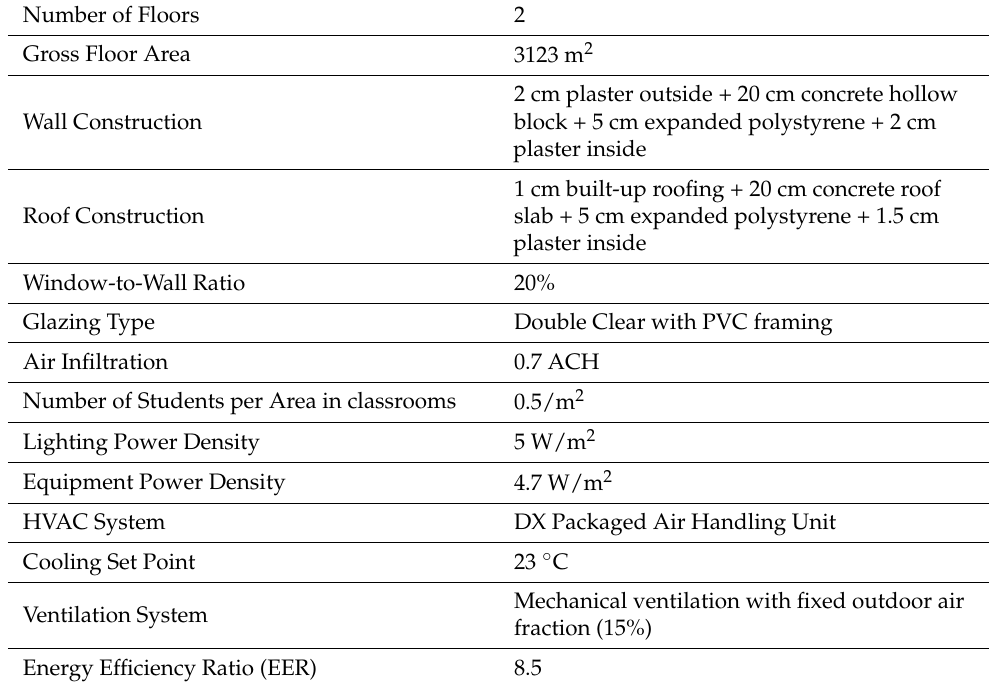
Figure 2. Monthly energy consumption before and after calibration of the modeled school in Jeddah, KSA. Table 1. Main characteristics of the building energy model for the